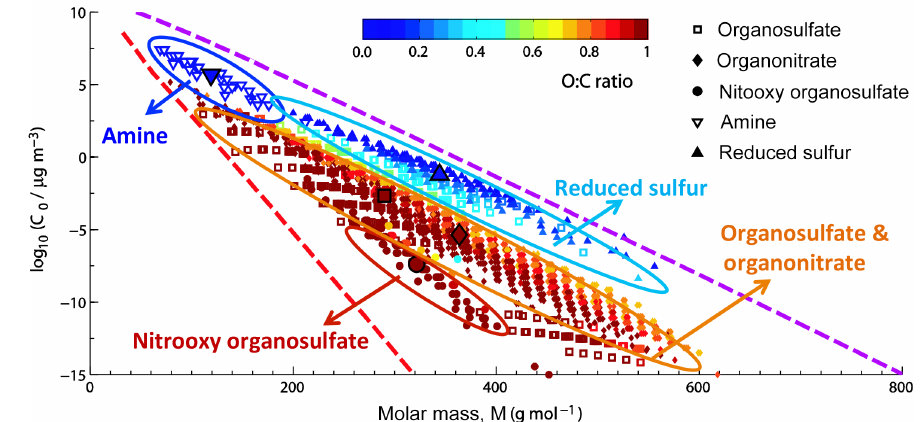
Figure 8. Molecular corridors of saturation mass concentration ( C 0 ) vs. molar mass ( M) for organosulfate, organonitrate, nitrooxy organosul- fate, amine, and reduced sulfur compounds collected from outdoor observations (Table 2). The small markers represent individual compounds color-coded by O : C ratio. The larger symbols indicate surrogate compounds with the mean values of M , C 0 , and O : C ratio.